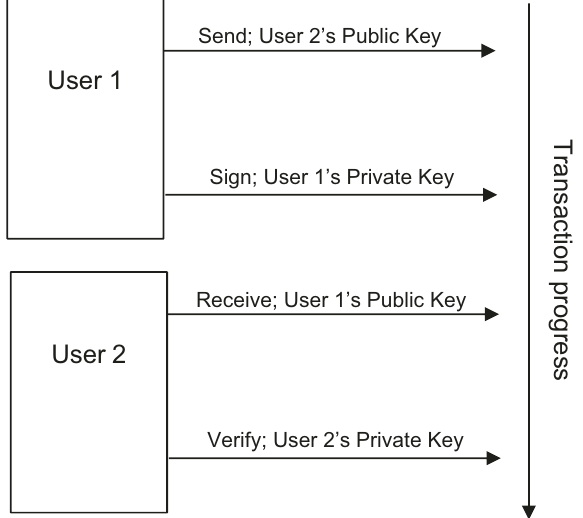
Fig. 1 Progress of a Blockchain transaction. Public-key cryptogra- phy creates a public and a private key for each user, using a one-way hash function to create the public from the private key. The public keys are used by the sender and receiver of a transaction to identify each other. Private keys remain undisclosed, and are used by the sender and receiver to sign and verify transactions, respectively. Here, User 1 sends a transaction to User 2, using User 2 ’ s Public key. User 2 receives the transaction, identi fi ed as having been sent by User 1 ’ s public key.